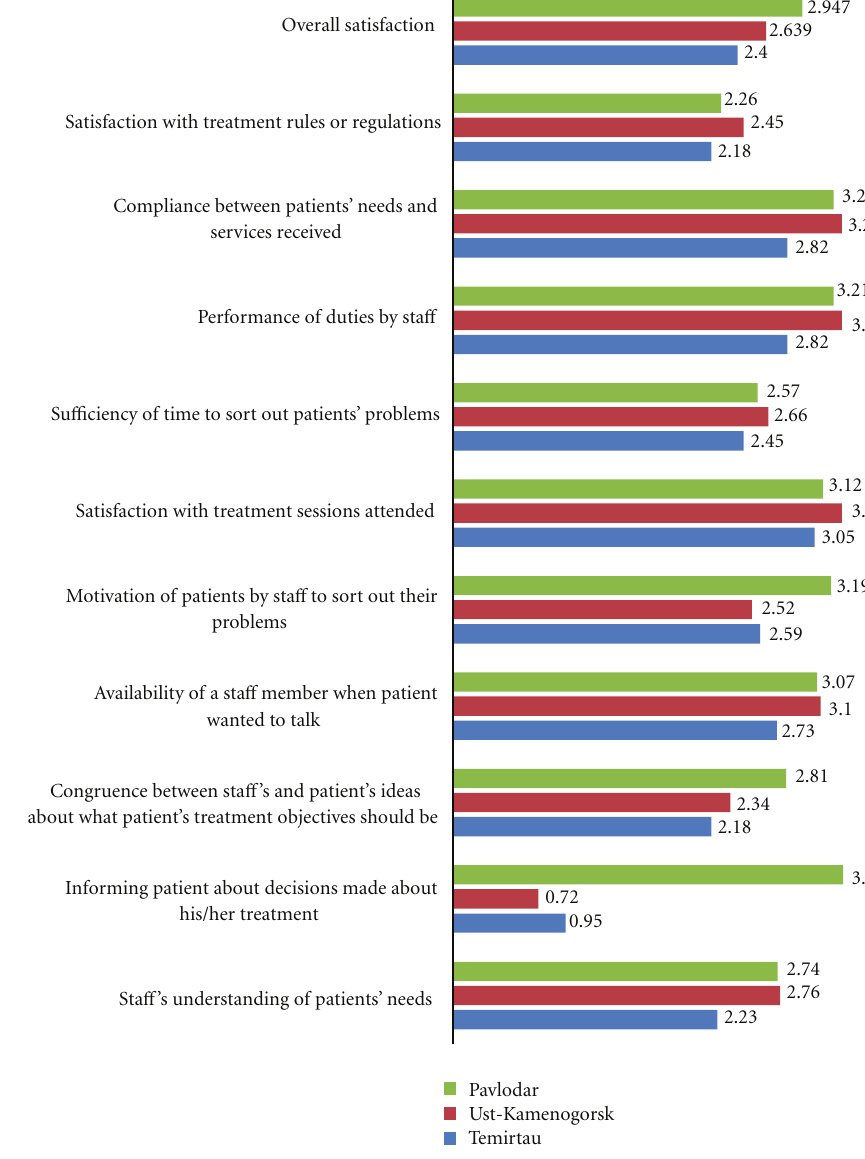
reflect MAT patients’ “normal” drug use patterns prior to facing di ffi culties in sourcing